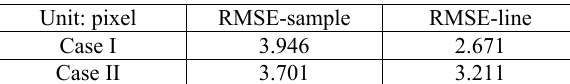
Table 1. Comparison